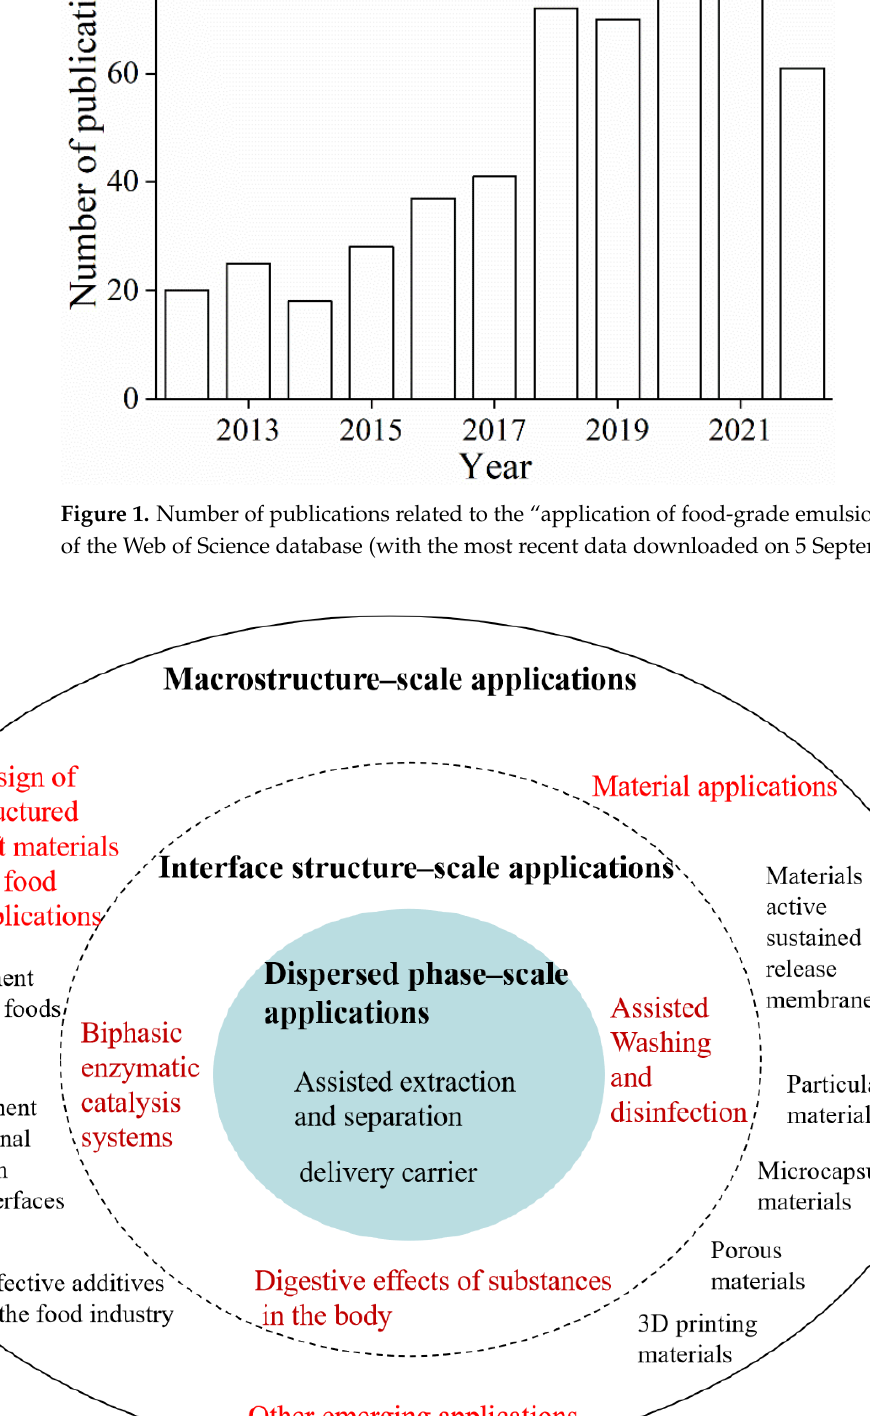
Figure 1. Number of publications related to the “application of food-grade emulsions” from a search of the Web of Science database (with the most recent data downloaded on 5 September 2022).